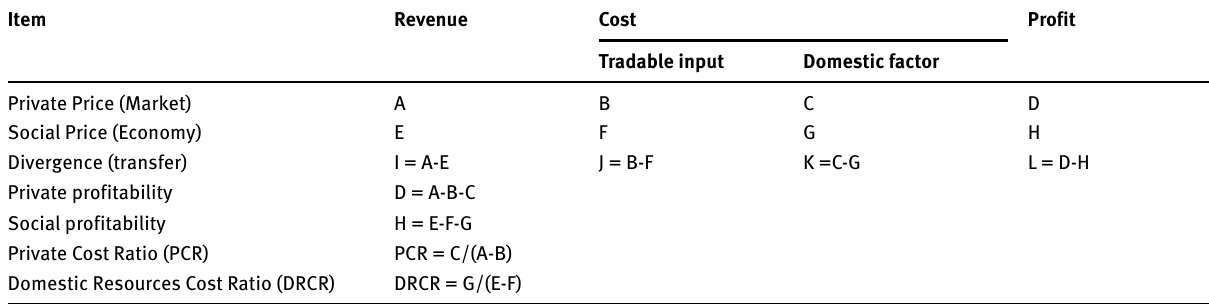
Table 1: Framework of PAM